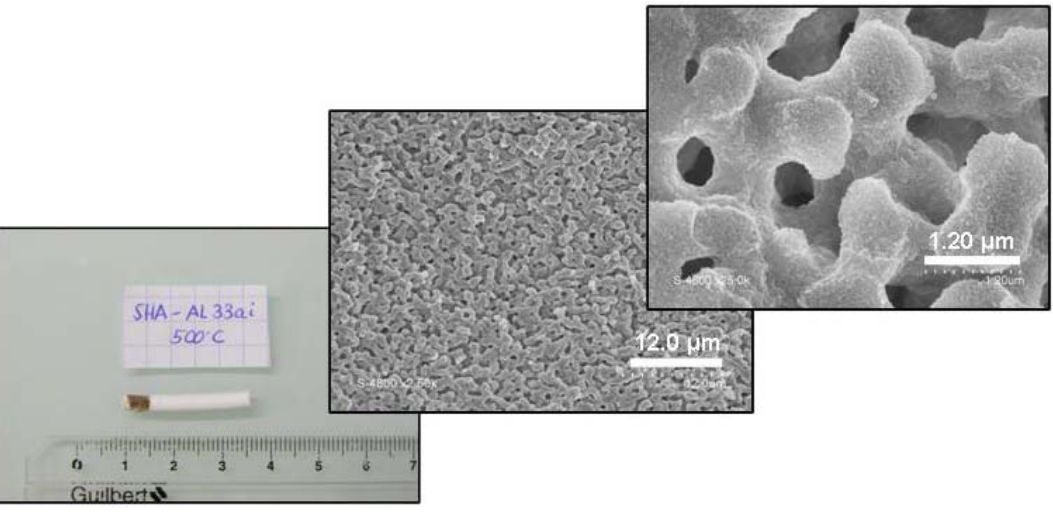
Figure 5. Photograph of the alumina monolith after calcination at 500 °C and the corresponding SEM pictures showing its isotropic and homogeneous macroporous network (macropores ~1 µm) and its skeleton (thickness ~1